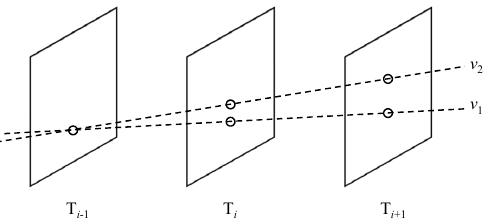
Figure 6. The space positions of space debris at different motion speeds. The space debris cross three consecutive frames at two different speeds, where v 2 > v 1